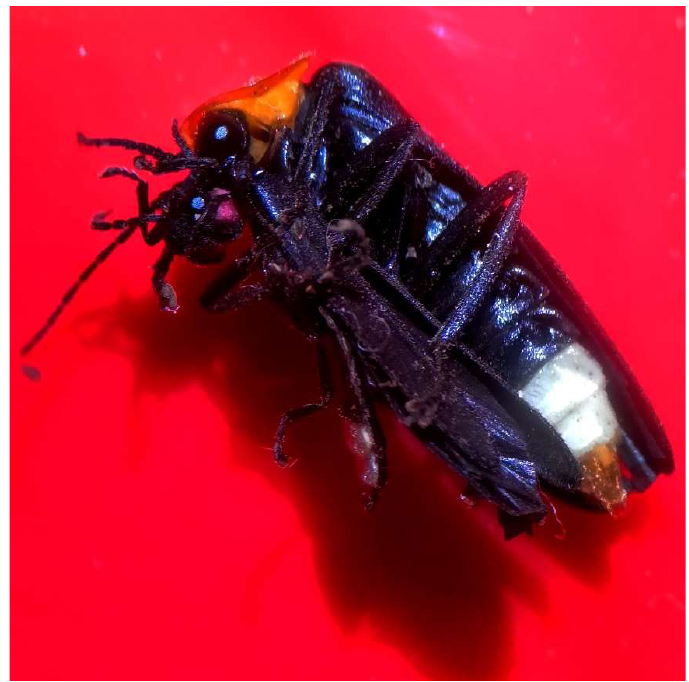
Figure 2. Experimental female Photuris lugubris (right) feeding on a male Photinus palaciosi (left). Notice that the prey is almost decapitated.